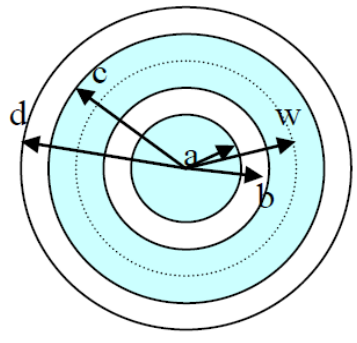
Figure 3. Four-phase coaxial cylindrical model.